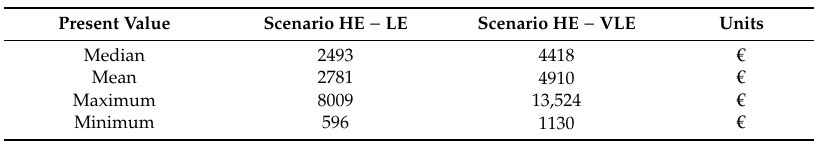
Table 6. Overall economic results.